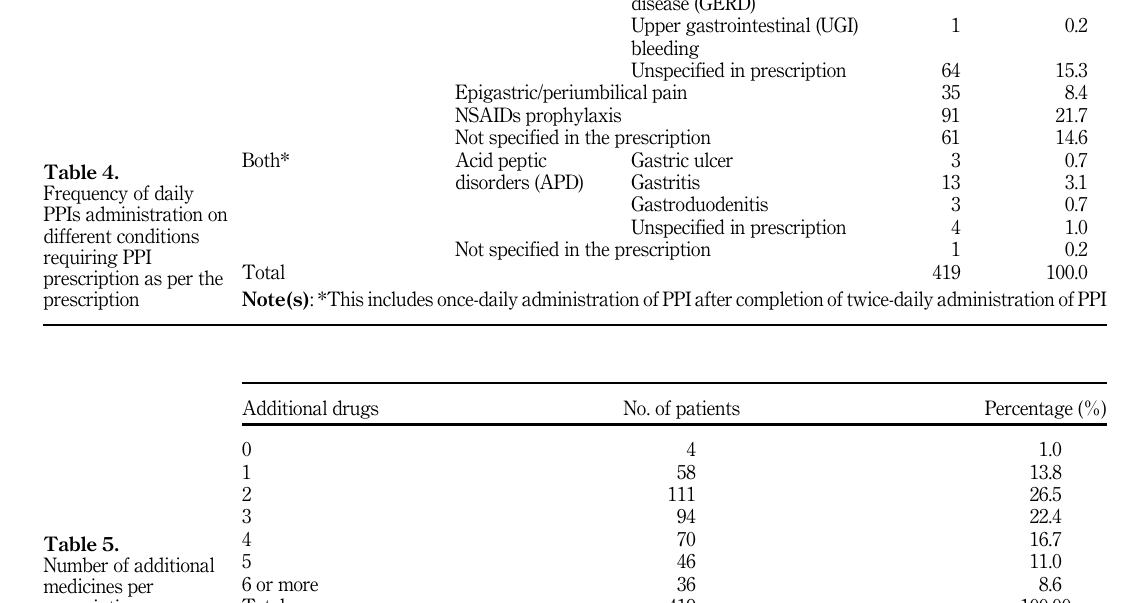
Table 5. Number of additional medicines per